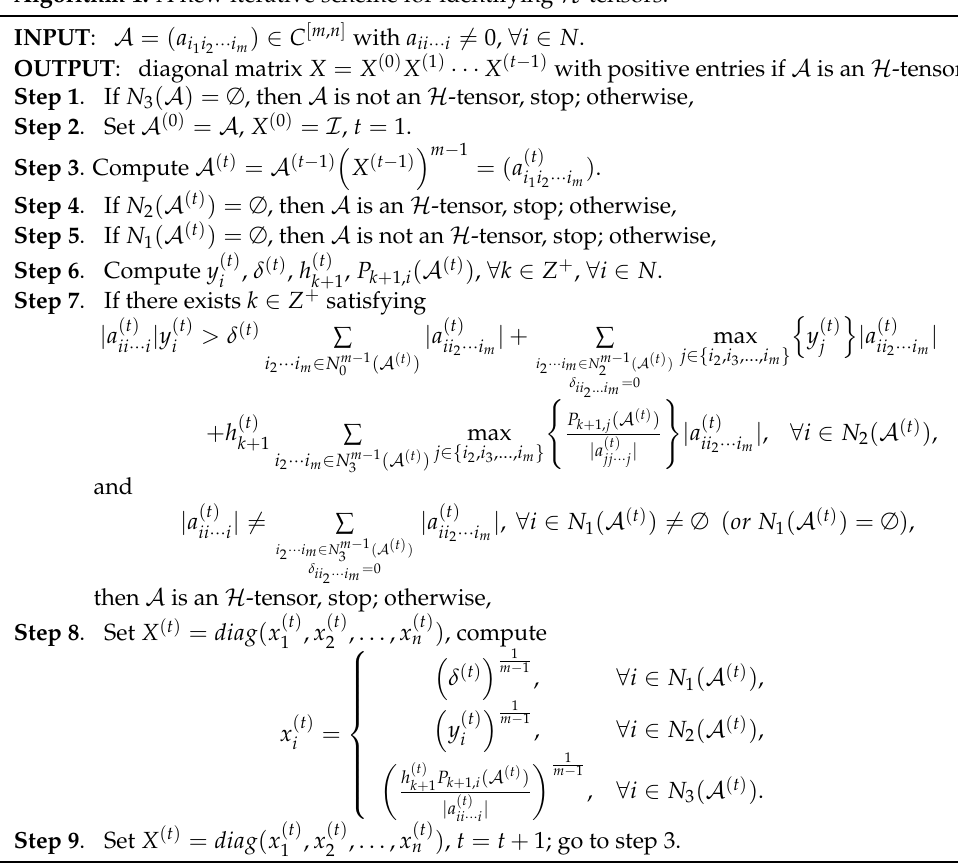
Algorithm 1: A new iterative scheme for identifying H